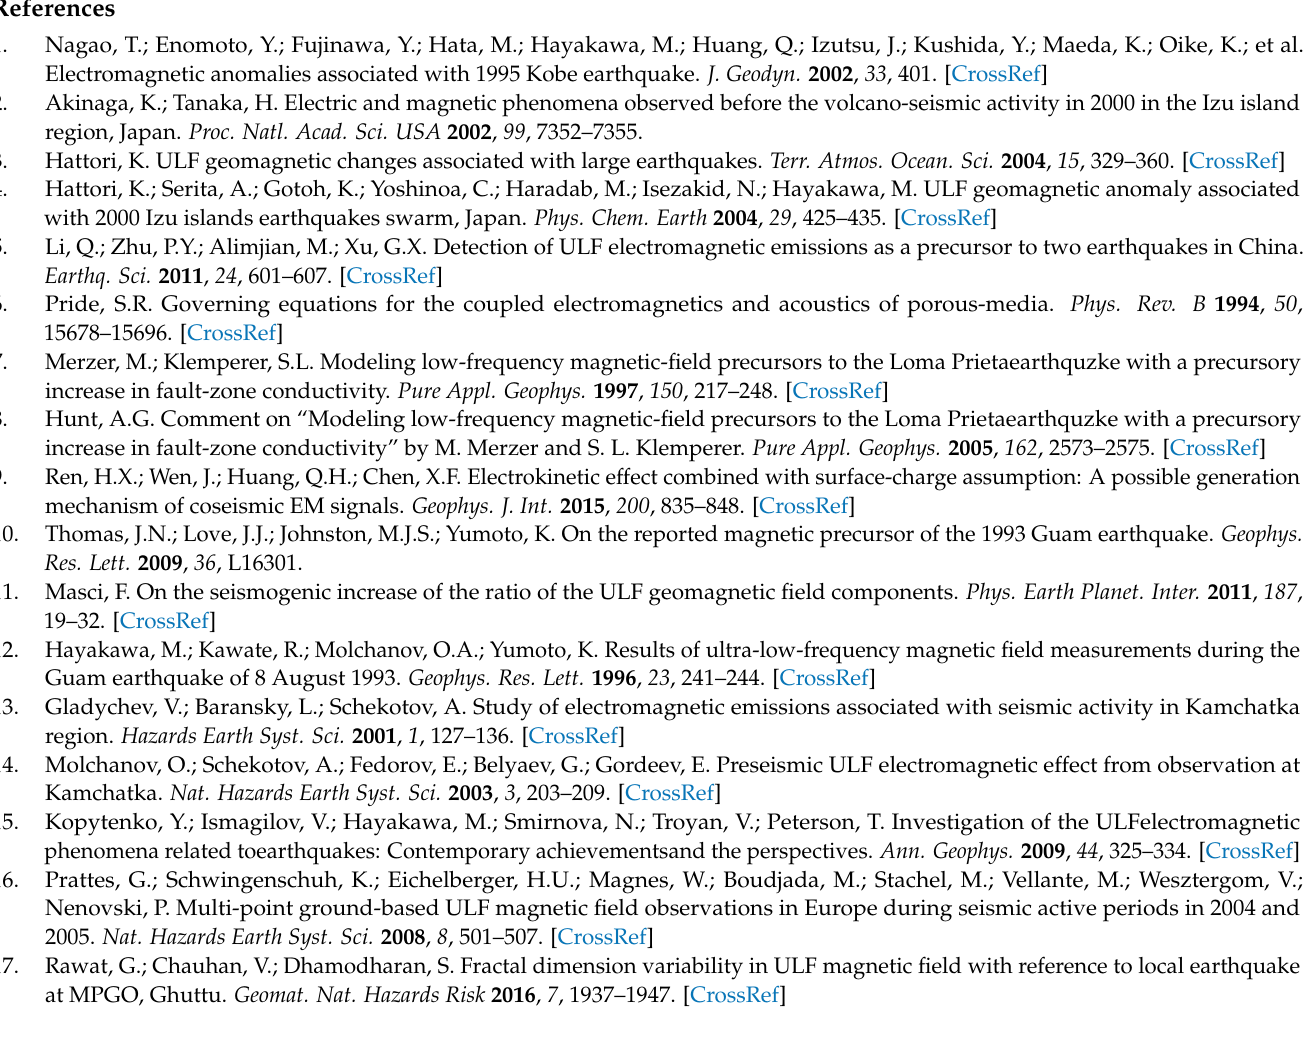
dex. Figure S4: Polarization ratios of Y ZH at (a) CDP, (b) GLM, and (c) CNH stations at approximately 0.1 Hz during 2013. Figure S5: Polarization ratios of Y ZH at (a) KSH, (c) CNH stations and Y ZG at (b) KSH, (d) CNH observatories within 0.003–0.02 from 2014 to 2017 and (e) Dst index. Figure S6: Scatter diagrams of magnitude and epicentral distance for (a) 37 and (b) 30